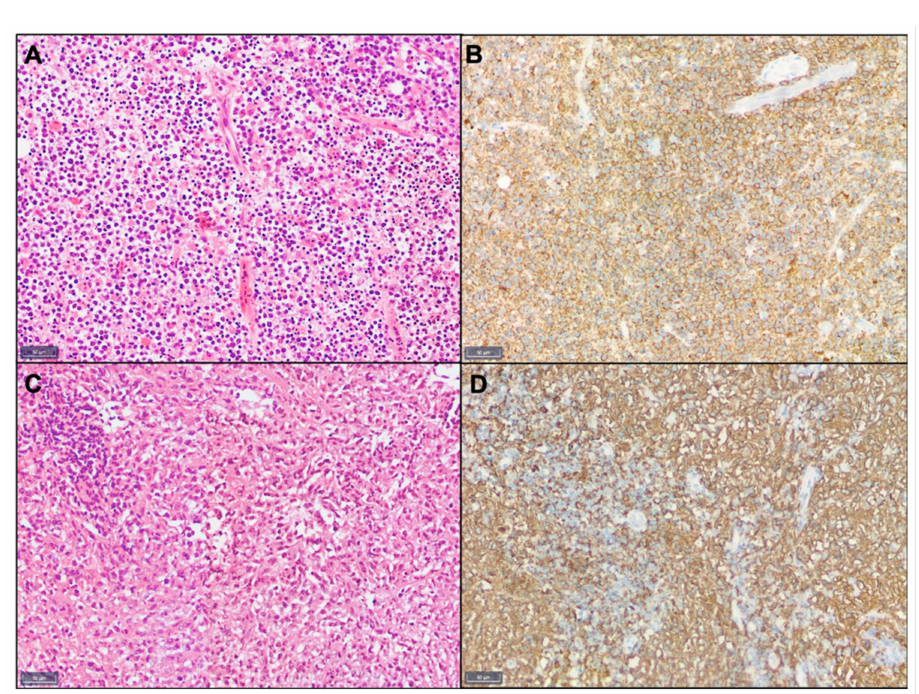
Figure 1. Example of histopathology. Shown are HE ( A , C ) and CD20 immunohistochemistry ( B , D ) of a manifestation of a diffuse large cell lymphoma ( A , B ) and a follicular lymphoma ( C , D ). Scale bars: 50 µ